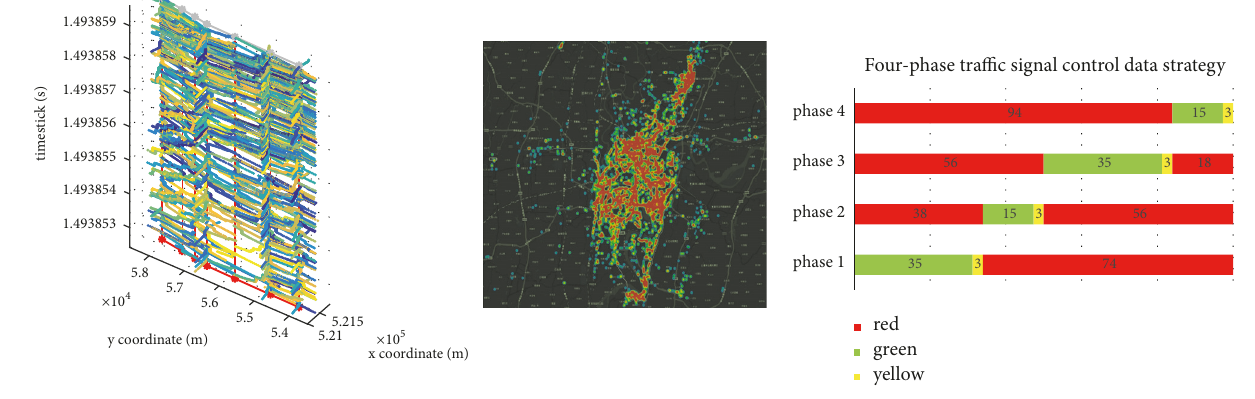
Figure 1: New traffic data